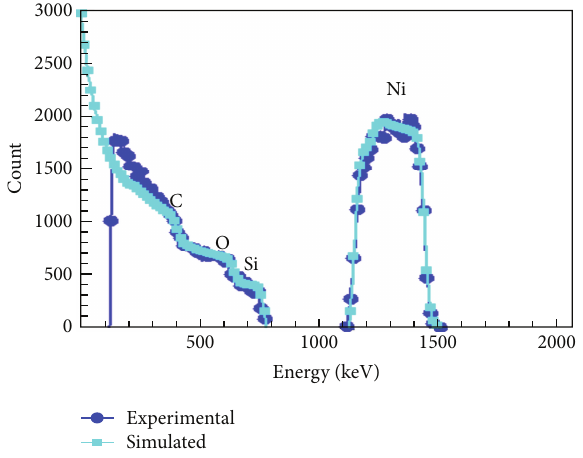
Figure 3: RBS spectra, experimental and simulated results of C-Ni film deposited at 600